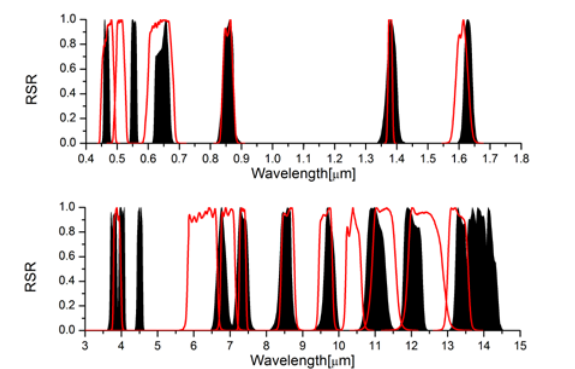
Figure 2. Relative spectral response function of AMI (red lines) and MODIS (black